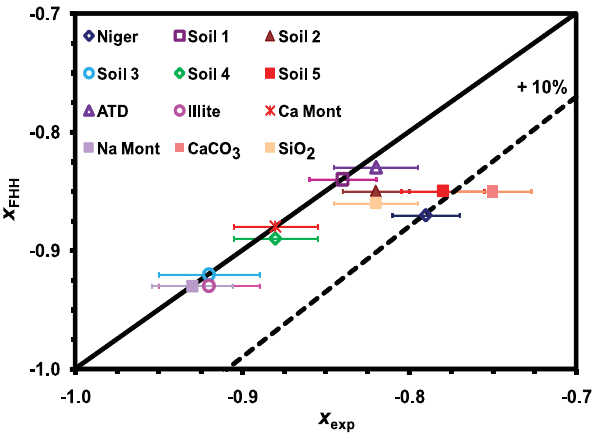
Fig. 7. Comparison of x exp and x FHH for dust and clay/mineral types presented in Table 1. Dashed line represents +10% deviation from the 1:1 line. Error bars represent deviation in x exp due to the uncertainty in D dry